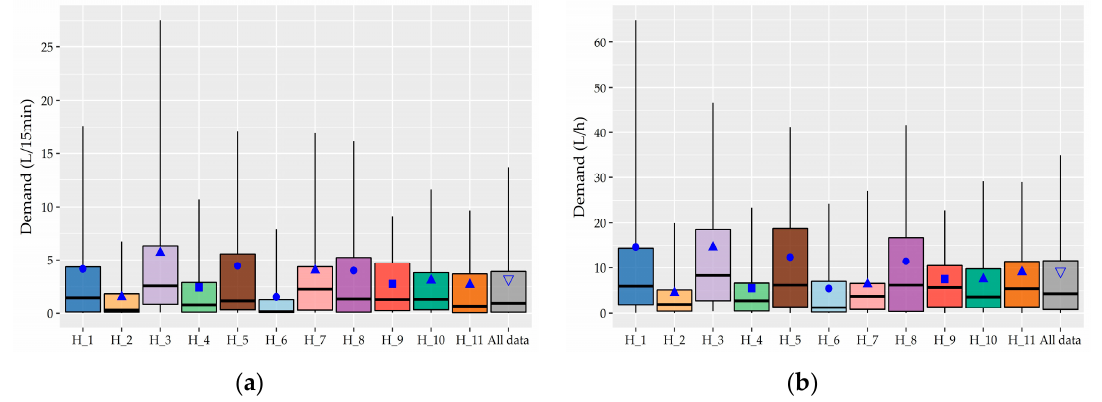
Figure 1. Box plots depicting the nonzero 15-minute ( a ) and hourly ( b ) per capita water demand of the 11 households and the unified series (indicated as “All data”). The blue points represent the mean value of the samples where dot is used for a “family with kids”, triangle is used for a “family of adults”, a square is used for “adults”, and an inverse triangle is used for the mean of the unified series. A small variation among households is also noted in the median of the nonzero records with the